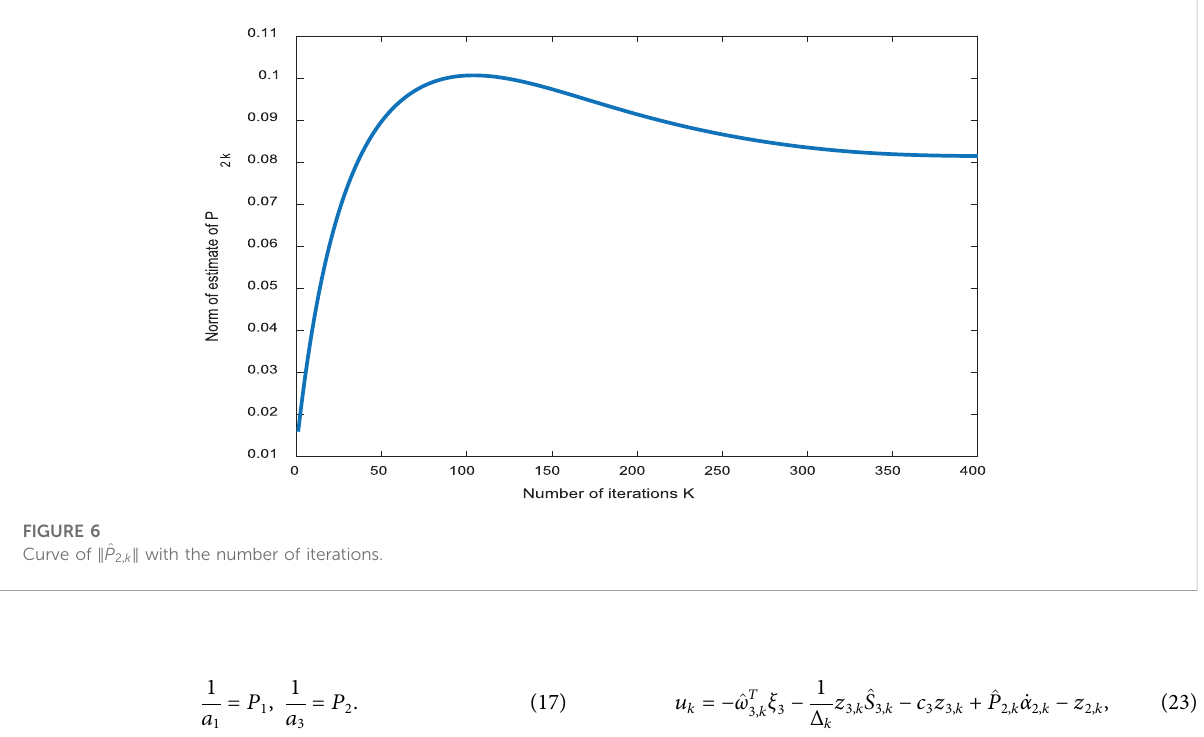
FIGURE 6 Curve of (cid:3) ^ P 2 , k (cid:3) with the number of